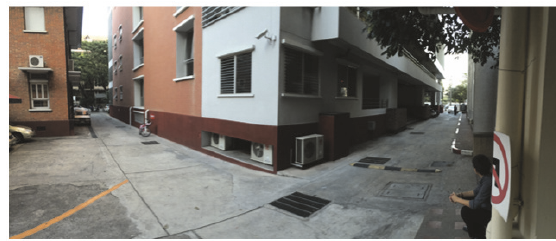
Figure 7: Centennial Building.